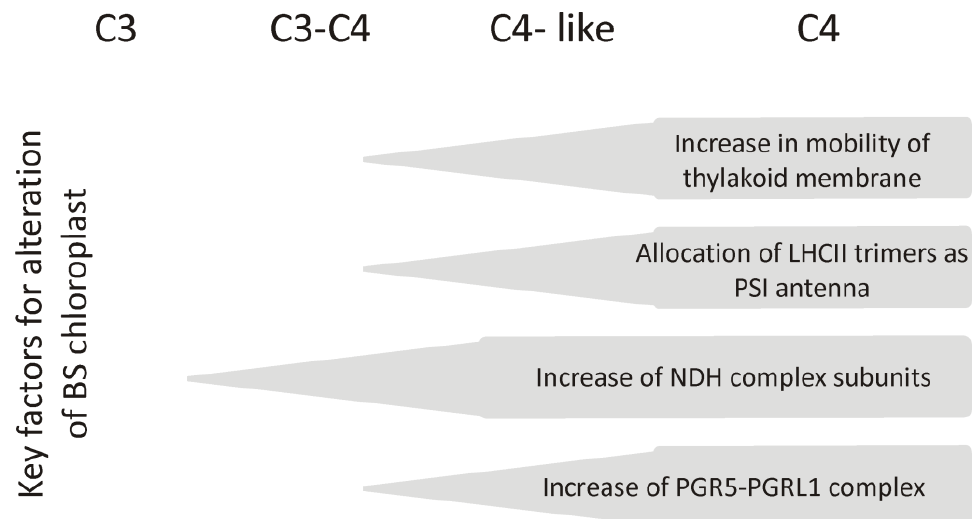
Figure 4. The scheme of alterations that take place in bundle sheath chloroplasts (BS) during the evolutionary process from C3 to C4 in the Flaveria genus. As described by Munekage and Taniguchi [38], in species representing C4 photosynthesis, the content of complexes involved in cyclic electron transport increased and the allocation of LHCII trimers as the PSI antenna occurred due to changes in the organization of thylakoid membranes.